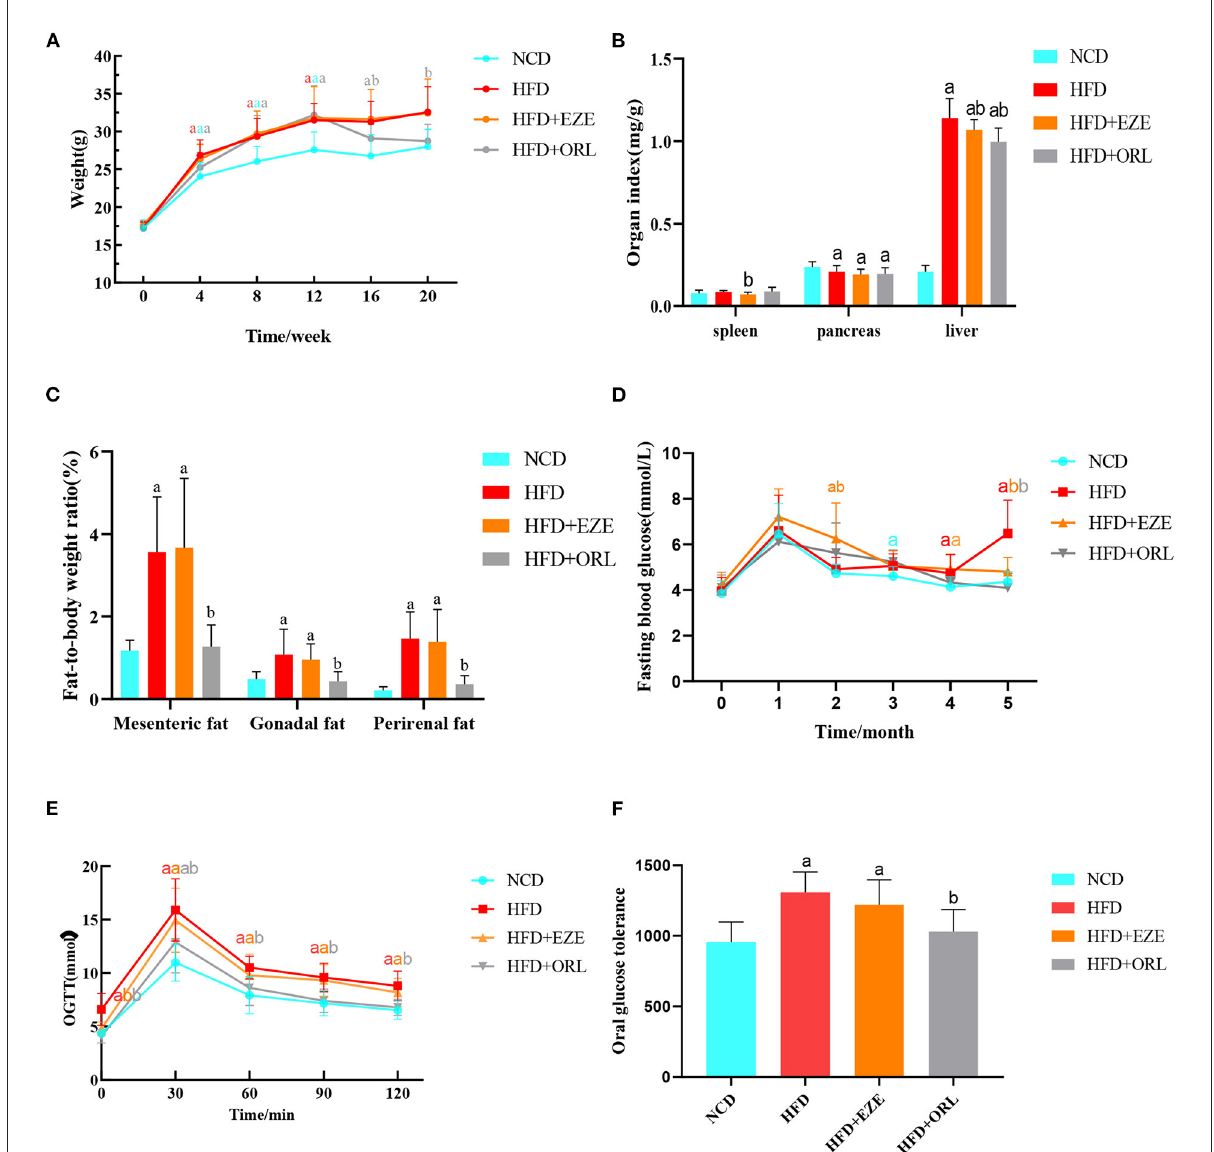
FIGURE1 Body weight, organ indexes, visceral fat-to-body weight ratio, and the glucose response of mice. (A) The body weight of mice in different groups. (B) Organ (spleen, pancreas, and liver) indexes of mice. (C) Visceral fat-to-body weight ratios of mice. (D) Determination of fasting blood glucose levels of mice each month. (E) An oral glucose tolerance test (OGTT) was performed on mice in the 20th week. (F) Area under the oral glucose tolerance curve of mice. a: P < 0.05 compared with the NCD group. b: P < 0.05 compared with the HFD group. a in red: HFD group compared with NCD group. a in orange: HFD + EZE group compared with NCD group. a in gray: HFD + ORL group compared with NCD group. b in orange: HFD + EZE group compared with HFD group. b in gray: HFD + ORL group compared with HFD group. NCD, normal diet; HFD, high-fat diet; HFD + EZE, high-fat diet and intervention of ezetimibe; HFD + ORL, high-fat diet and intervention of orlistat; n = 19-20 per